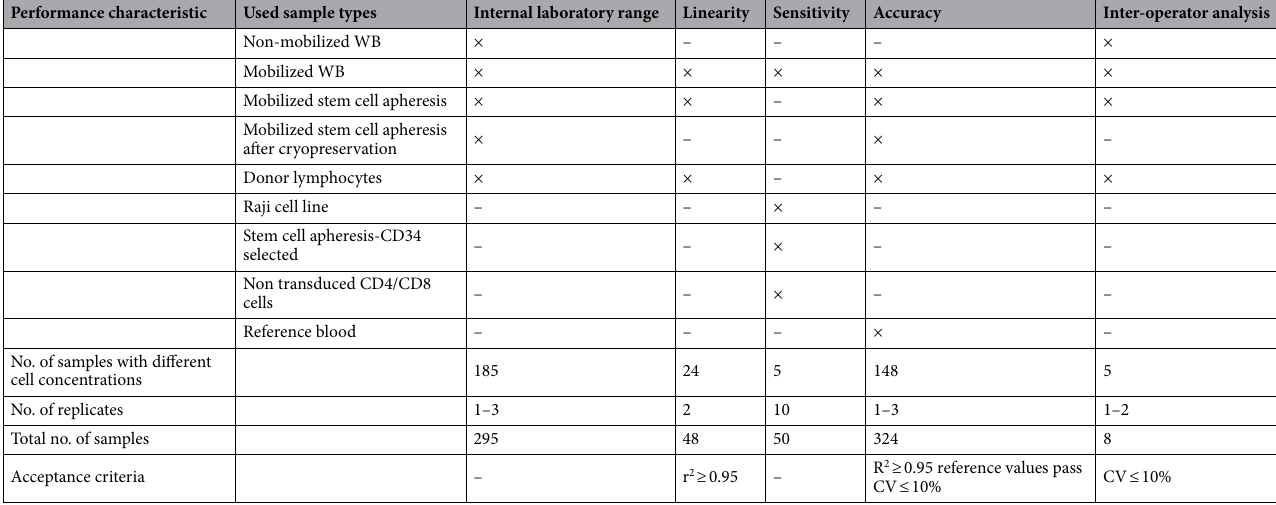
Table 1. Summary of the validation design for the pre-formulated dried reagent panel (CD45 FITC, CD34 PE, 7-AAD, CD3 PB, CD19 APC as well as absolute counting beads) measured with the flow cytometer Navios 10/3 with different sample types of standard